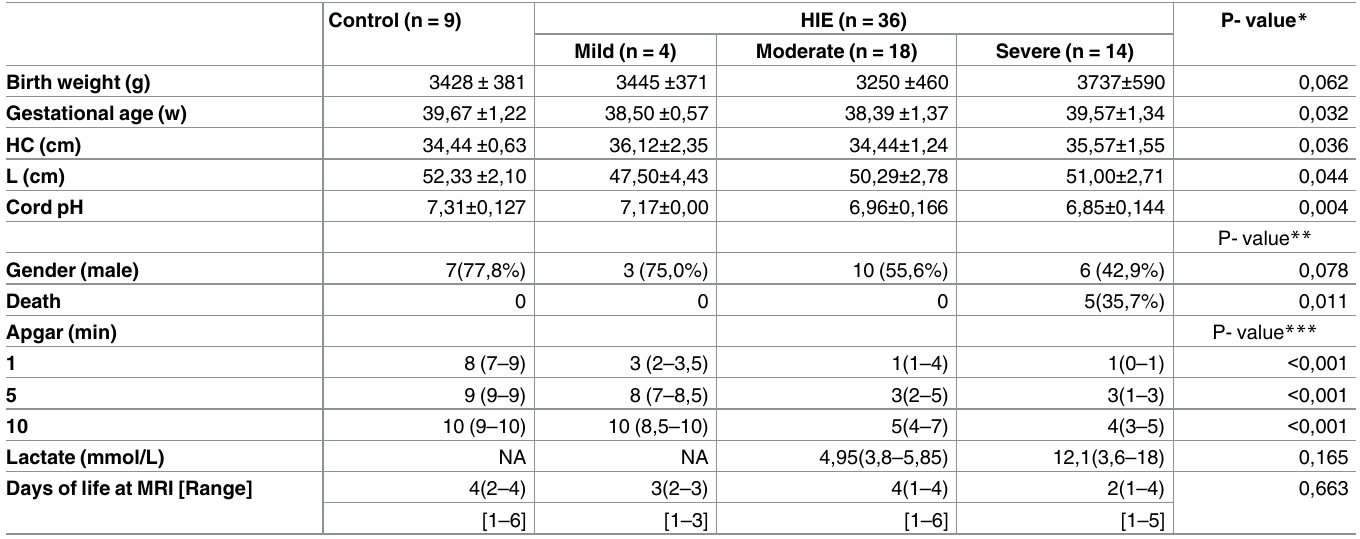
Table 1. General characteristics of the study population.